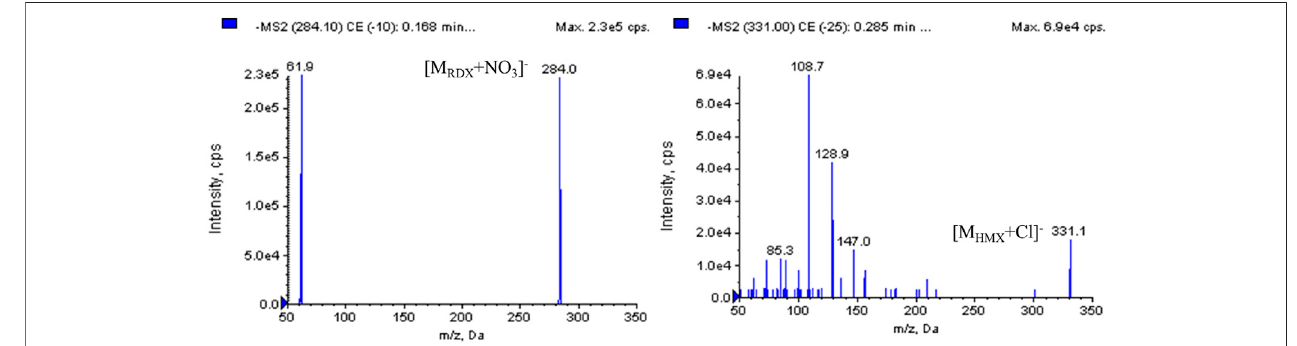
FIGURE 2 | The second-fragment mass spectra of RDX, HMX and